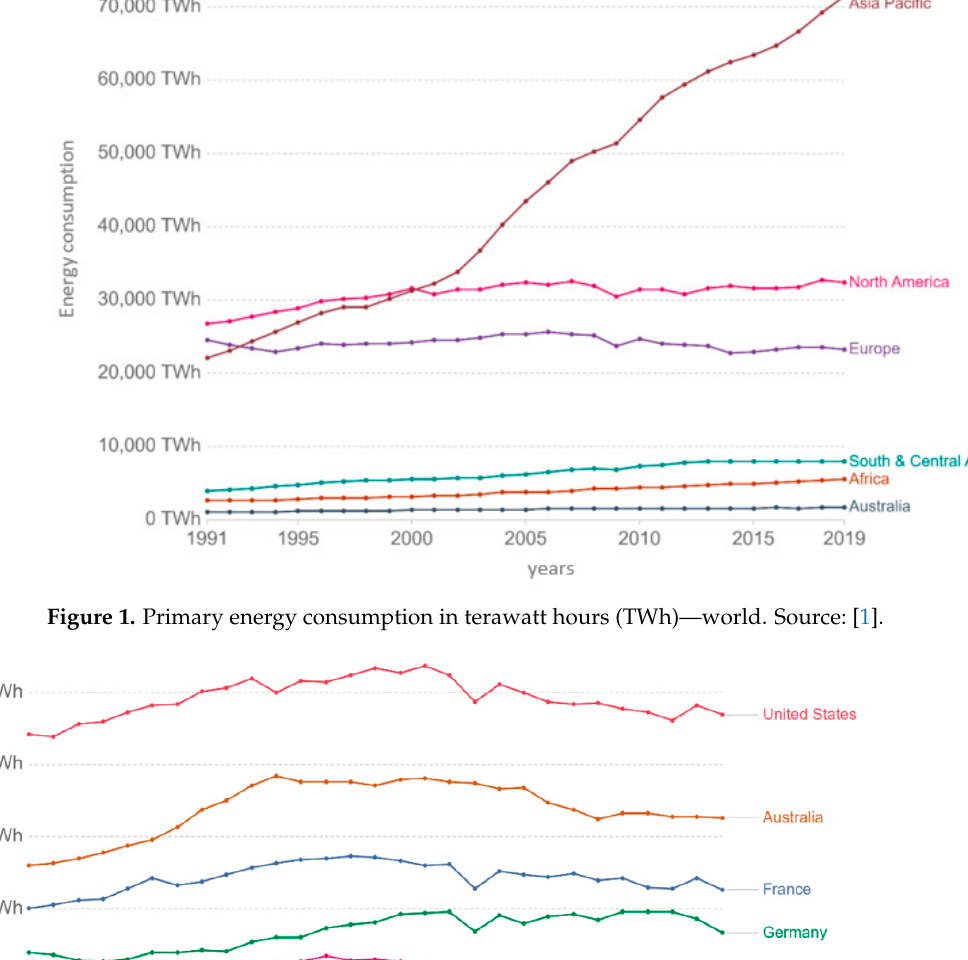
Figure 2. Per capita electricity consumption in kilowatt-hours (TWh)—selected countries. Source: [1].